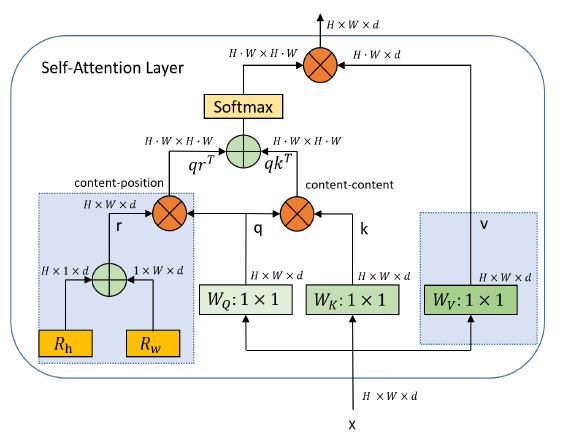
Figure 3. Multi-head self-attention (MHSA) layer used in the BoT